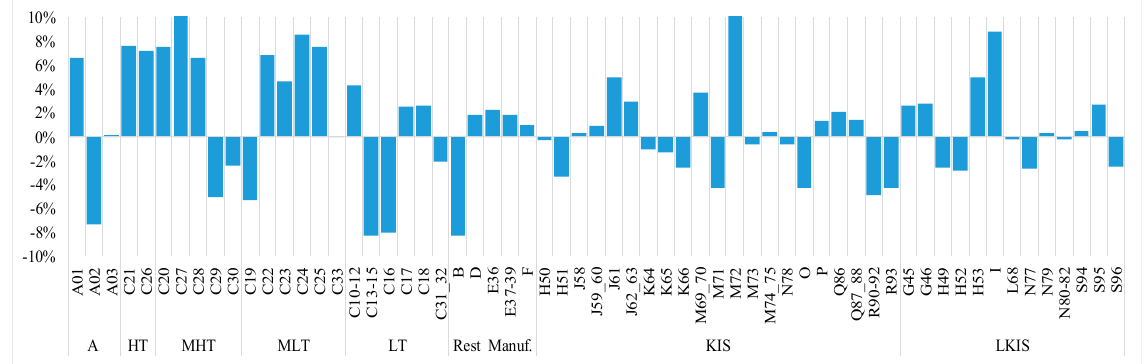
Figure 4. The impact of restructuring to the value-added of the Czech economy. The horizontal axis shows the sectors of economic activity, and the vertical axis shows the percentage changes of the examined measure.